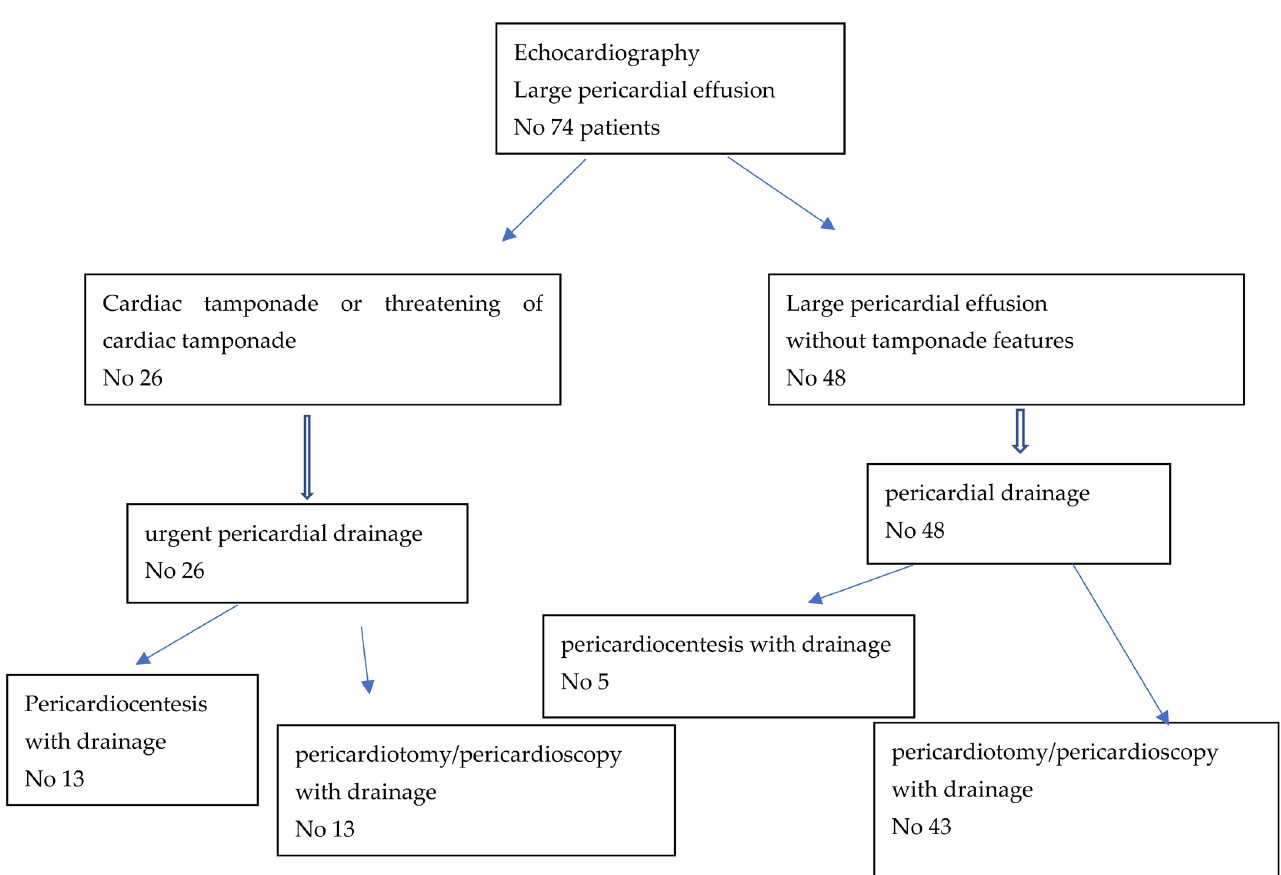
Figure 4. Types of procedures used in patients with large pericardial effusion.